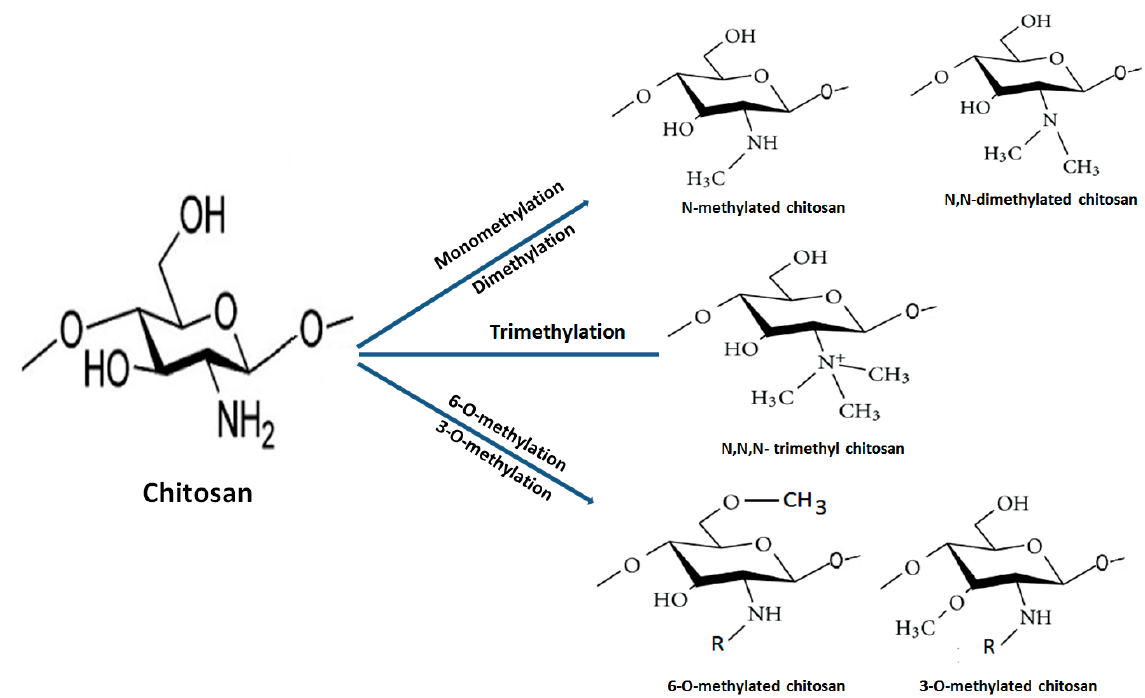
Figure 5. Different pathways for synthesis of methylated chitosan from native chitosan.